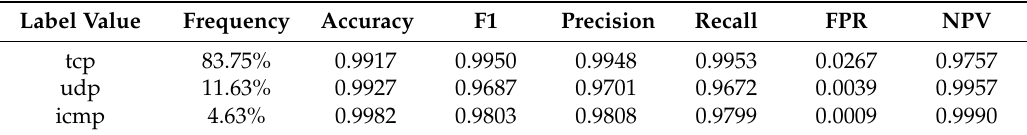
Table 4. Detailed performance metrics for reconstruction of all features values when feature: ‘ protocol’ is